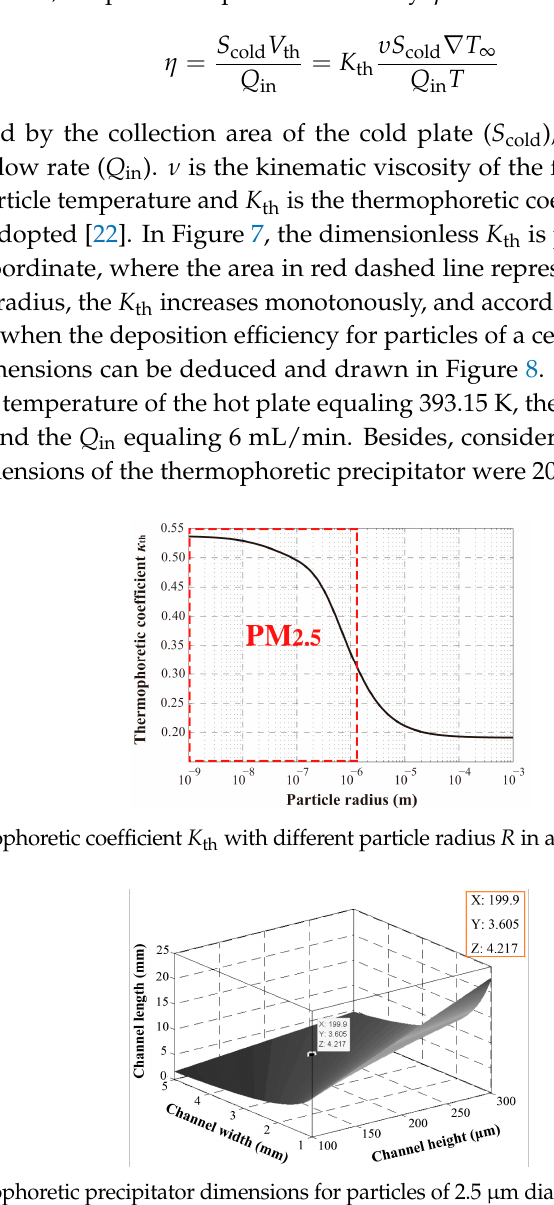
Figure 8. Thermophoretic precipitator dimensions for particles of 2.5 µ m diameter under 100% deposition efficiency condition.